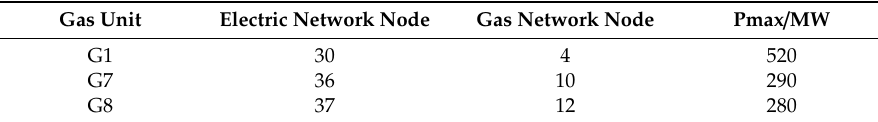
Table A1. Parameters of gas units.